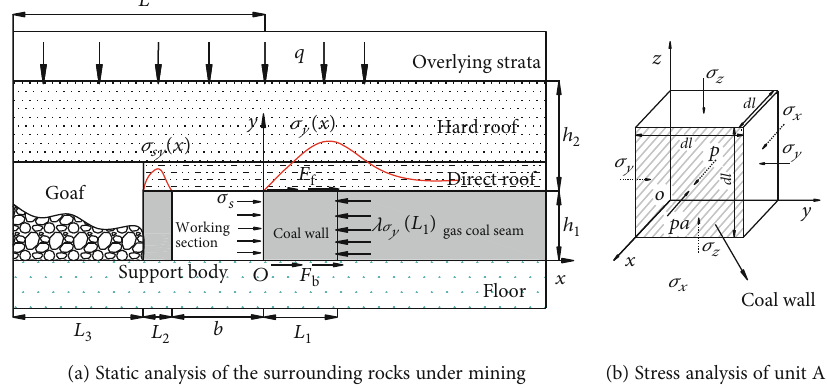
Figure 4: Mechanical model of the surrounding rocks under a hard roof during